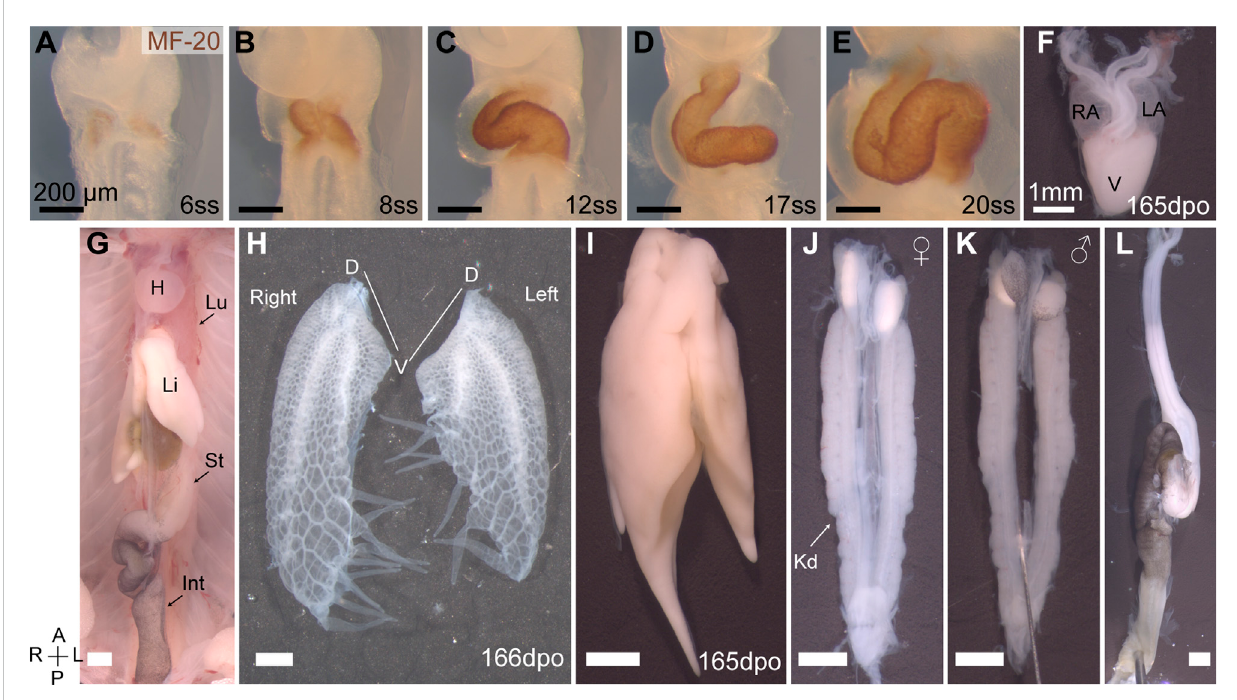
FIGURE 1 Organ asymmetry in veiled chameleon embryos. (A – F) Progression of heart formation and development. In (A – E) the formation of the heart is highlighted through immunohistochemical staining for MF-20. (F) The heart of pre-hatching stage embryos (165 dpo — days post oviposition) has three chambers — left and right atria (LA and RA, respectively) and one ventricle (V). (G) General overview of abdominal organs in 165 dpo embryo. Heart (H), lungs (Lu), liver (Li), stomach (St), intestine (Int) are labeled. (H) Lungs of a 166 dpo embryo have a single 3- chambered lobe on each side. The left lung is shorter than the right. Chameleons have unique diverticula on ventral ends of the lungs on both sides. Diverticula are arranged in two rows on the rightlung,andinasinglerowontheleftlung.Theleftlunghas5,andtherighthas3+4diverticula. (I) Theliverhasalargerlobeontherightside. (J,K) The urogenital systemofbothfemales (J) andmales (K) exhibitsL-Rasymmetrywiththeleftgonadbeinglowerthantheright.Kidneys(Kd)areelongated and lie fl at against the dorsal abdominal wall. (L) The gastrointestinal tract is relatively short, with stomach on the left side. The intestine posterior to the stomachhasasinglemajorloopandhaveblackpigmentation.Allpanelsshowventralview,unlessotherwisenoted.Anterior(A)isonthetop,posterior(P) is on the bottom, left (L) is on the reader ’ s right, and right (R) is on the reader ’ s left. All black scale bars are 200 μ m, all white scale bars are